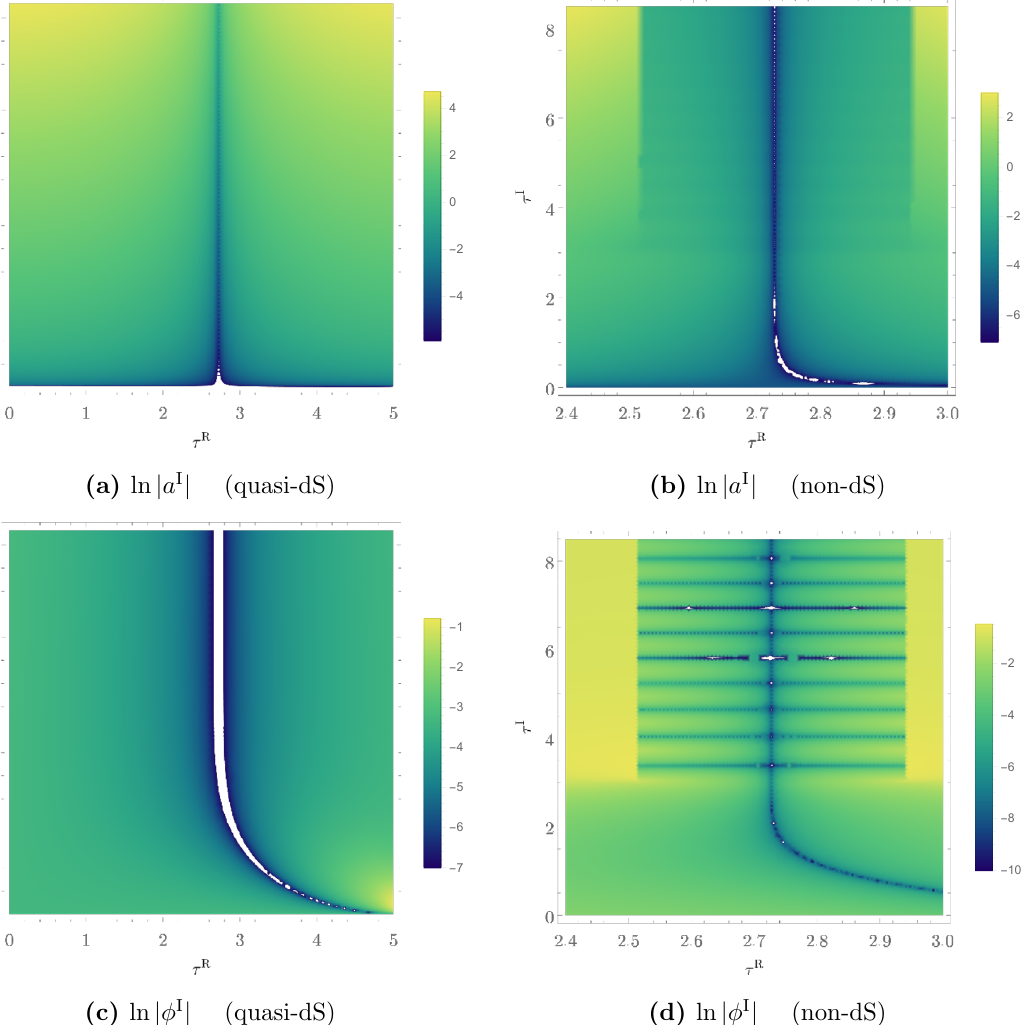
Figure 3. Density plots of the imaginary part of a (top) and of (cid:30) (bottom) on the complex (cid:28) plane. The color represents ln j a I j and ln j (cid:30) I j . (Left) The parameters are (cid:11) = 1 and (cid:30) SP = 6 : 06127 (cid:0) (3 : 61564 (cid:2) 10 (cid:0) 2 ) i , representing a quasi-dS regime. (Right) The parameters are (cid:11) = 0 : 01 and (cid:30) SP = 0 : 700503 (cid:0) 0 : 154991 i , representing a non-dS regime. The part of the nontrivial structure is focused, so the region around the origin is not